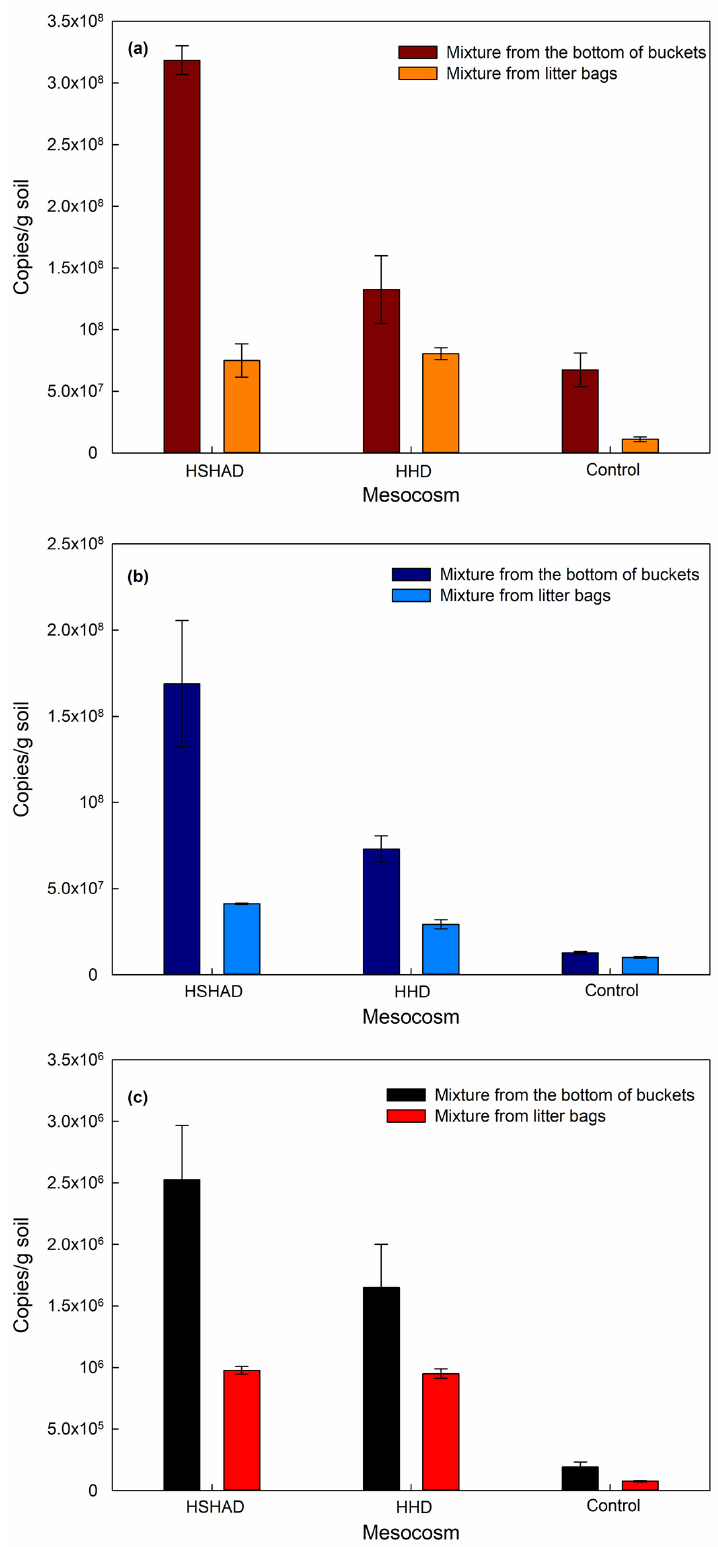
Figure 4. The abundance of denitrifying narG ( a ) , nirS ( b ) , and nosZ ( c ) genes in mesocosms (error bars represent standard errors of the mean value).